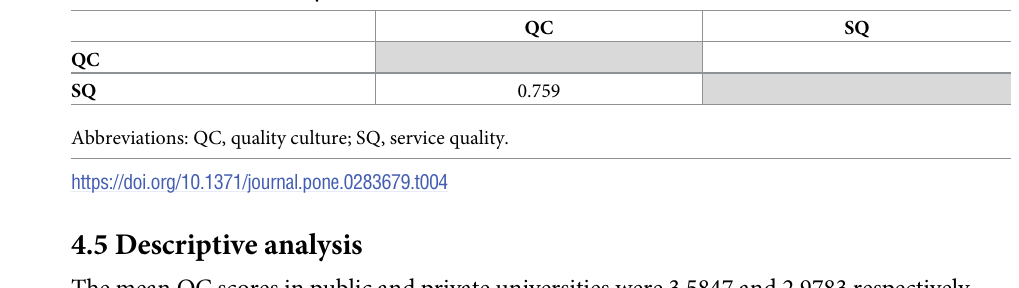
Table 4. Discriminant validity—HTMT ratio.